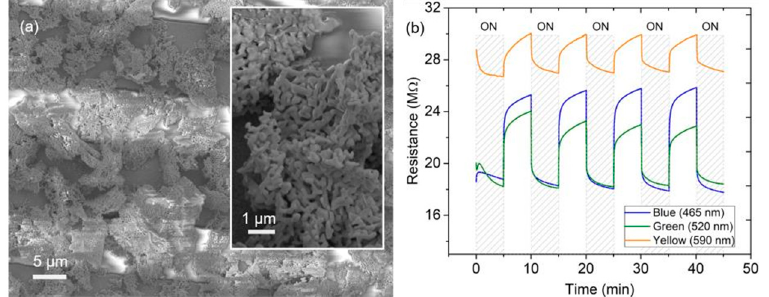
Figure 1. ( a ) SEM images of a gas sensor based on CaFe 2 O 4 nanopowders and ( b ) their behaviors under exposures of visible light from LEDs with different